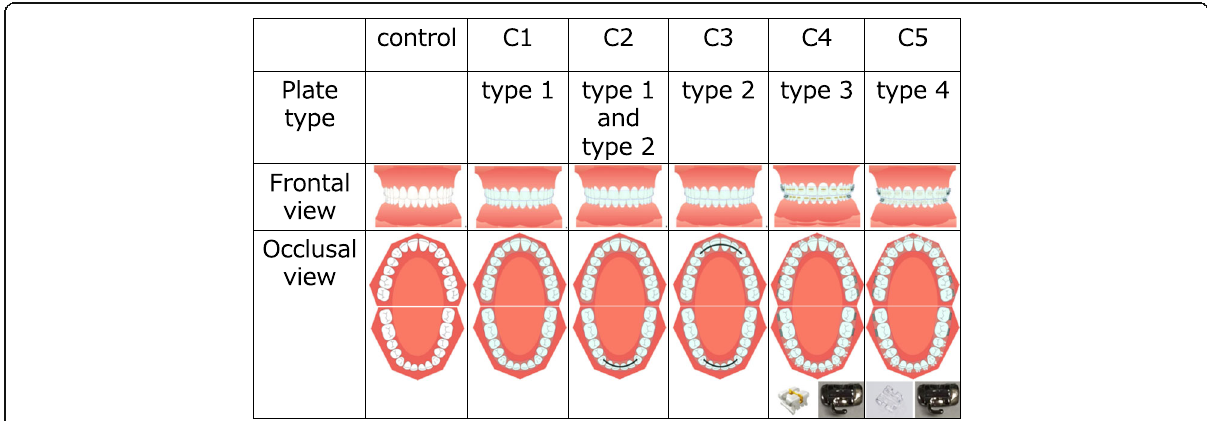
Fig. 1 Schematic diagrams of six conditions with four types of customized plates. Insets depict the brackets for anterior and molar teeth that are incorporated in each type of plate. In C2, the maxillary plate is type 1, and the mandibular plate is type 2